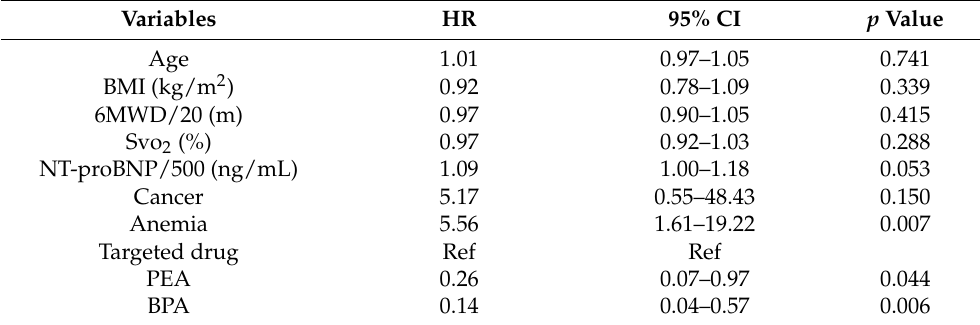
Table 2. Results of the multivariate Cox analysis after adjusting for the confounders.